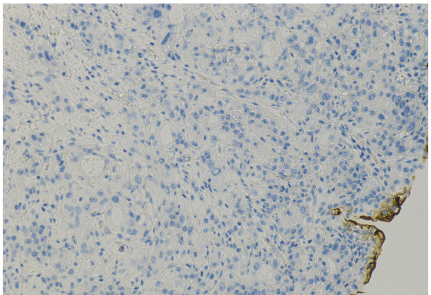
Figure 8: Bladder tumor with negative stain for Uroplakin in neoplastic